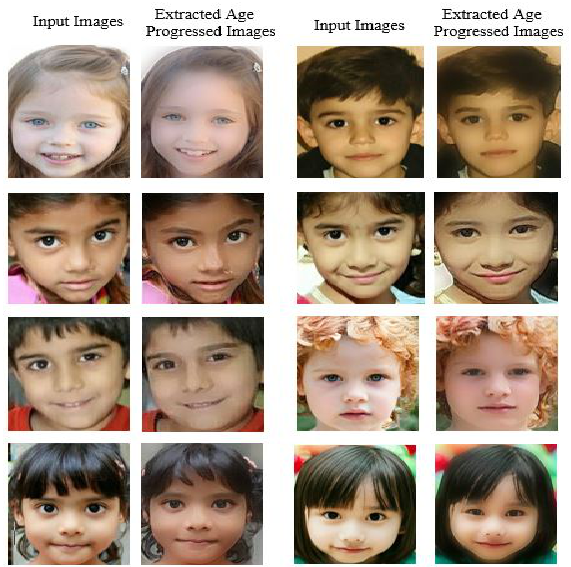
Figure 6. Retrieved Age progressed images of the proposed sys- tem